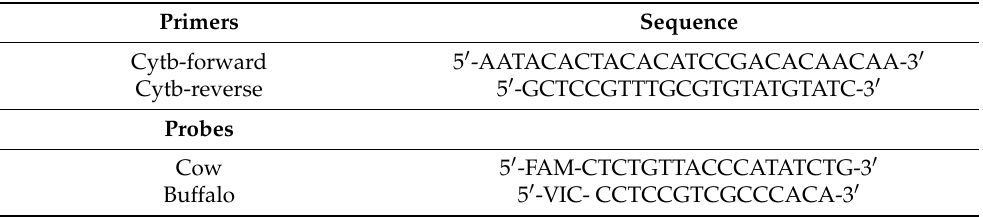
Table 1. List of primers and probes used for the ddPCR and qPCR